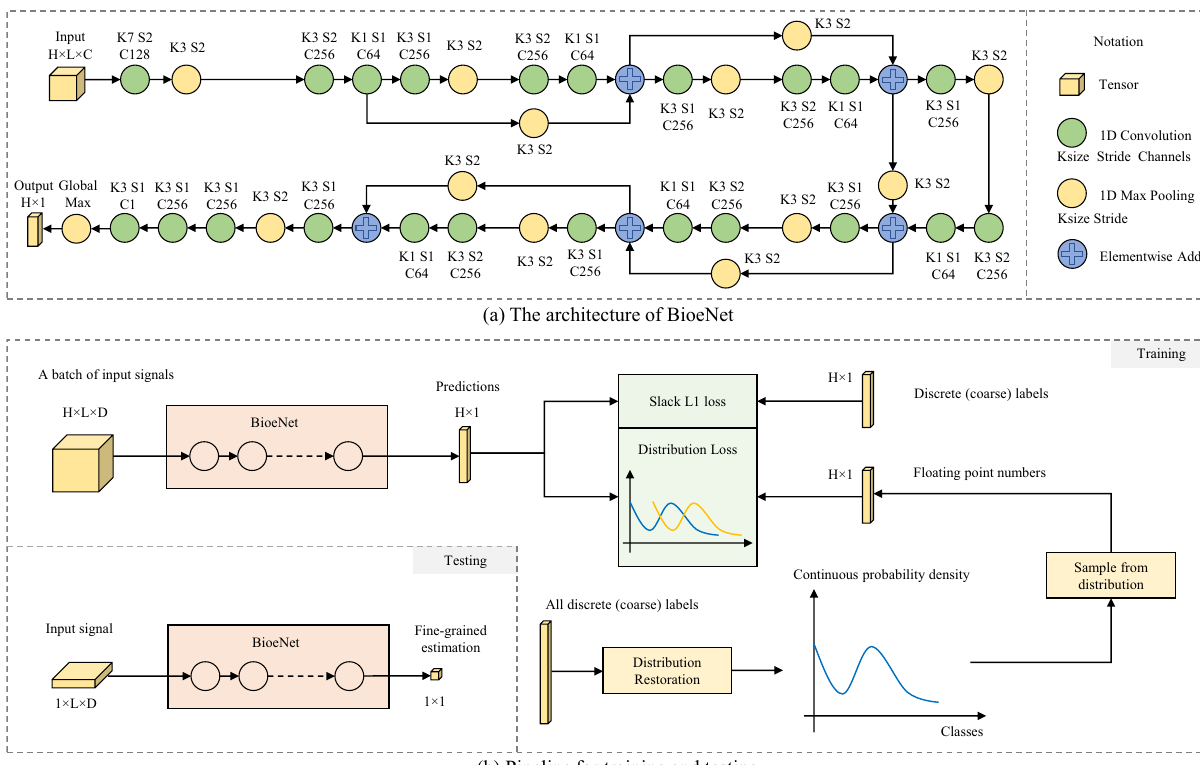
Figure 6. Network and pipeline overview. ( a ) illustrates the proposed BioeNet. Taking the bioelectrical signals as input, BioeNet predicts the physiological states indicated by these signals. The specific type of physiological states depends on training labels, for example, tremor severity. ( b ) Provides a systematic view of the training and testing